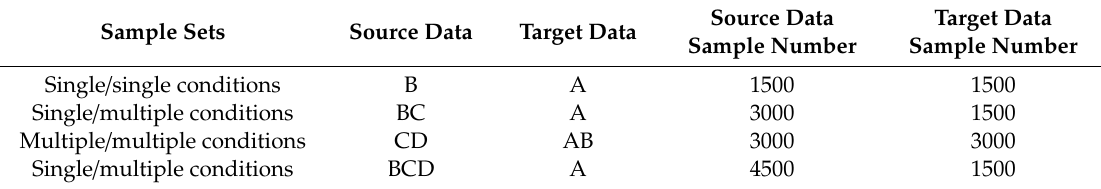
Table 2. Sample sets composition of rolling bearings under di ff erent working